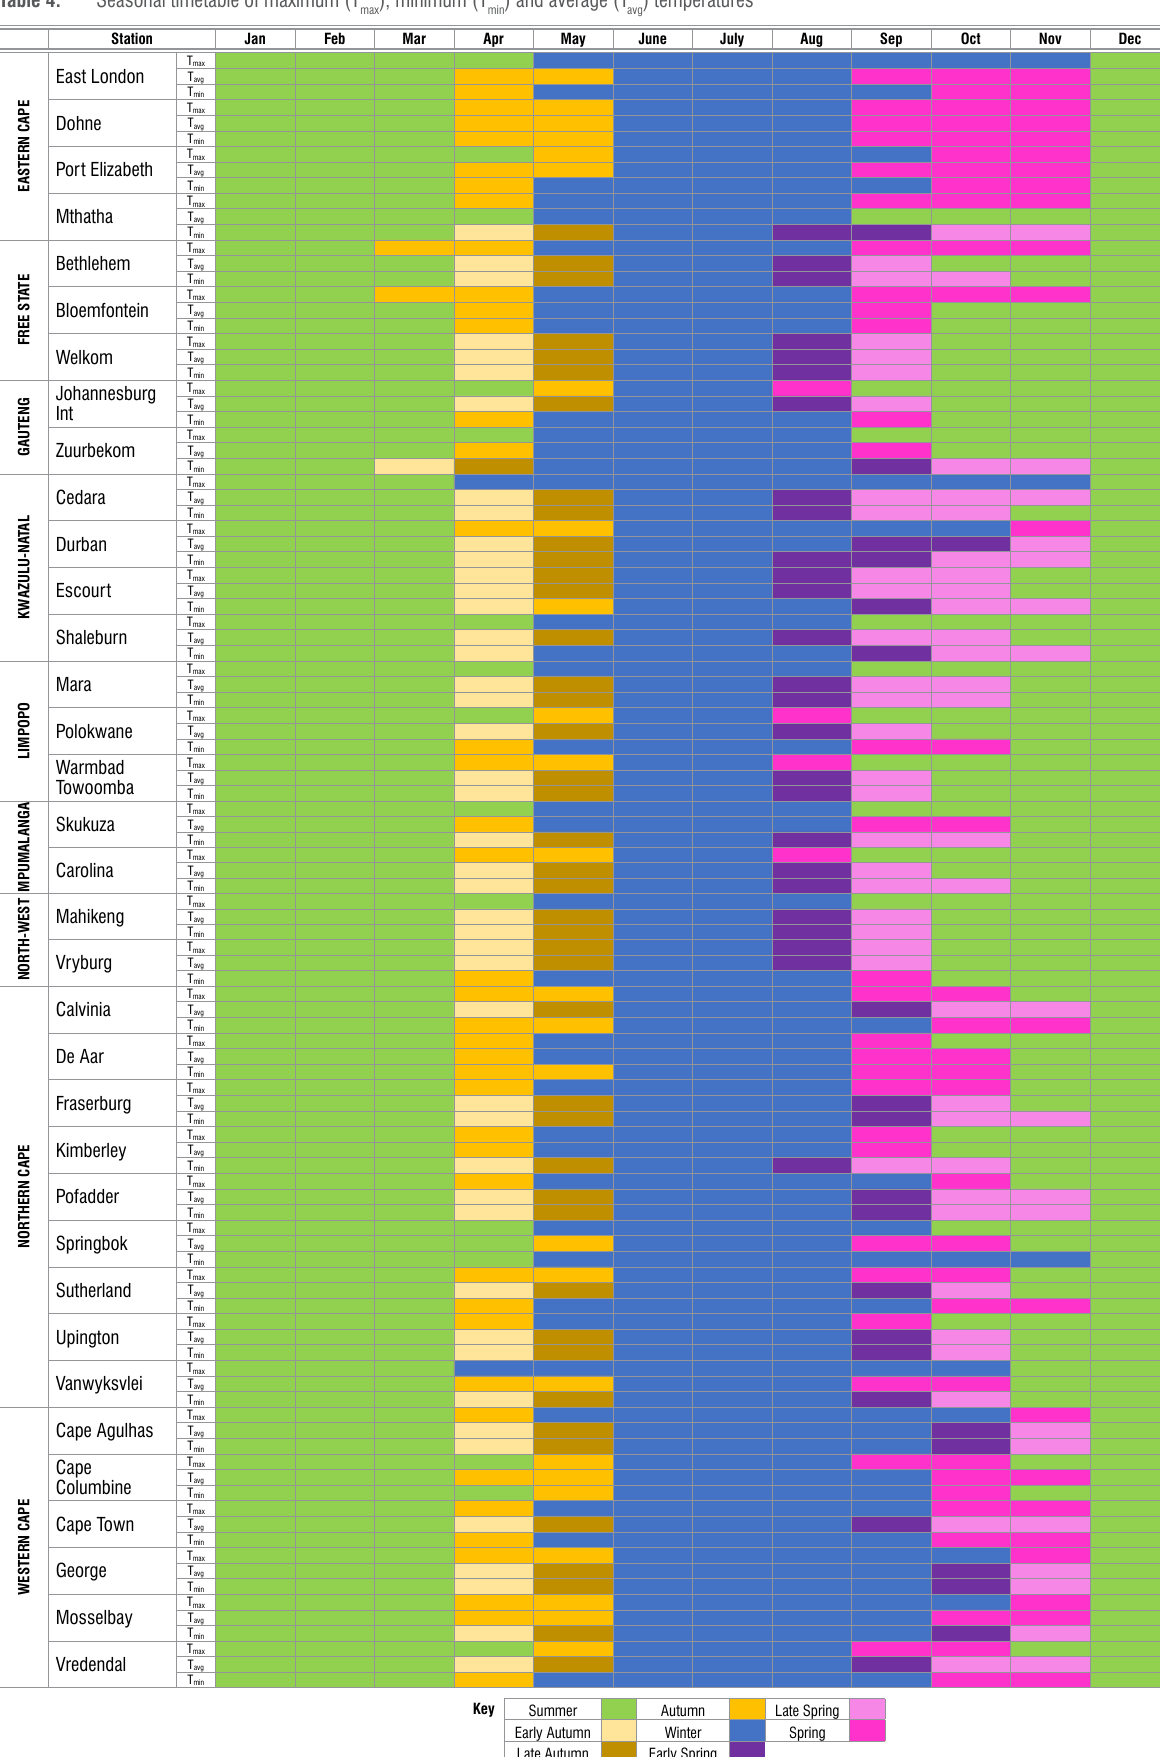
Table 4: Seasonal timetable of maximum (T Station Jan Feb Mar Apr May June July Aug Sep Oct Nov